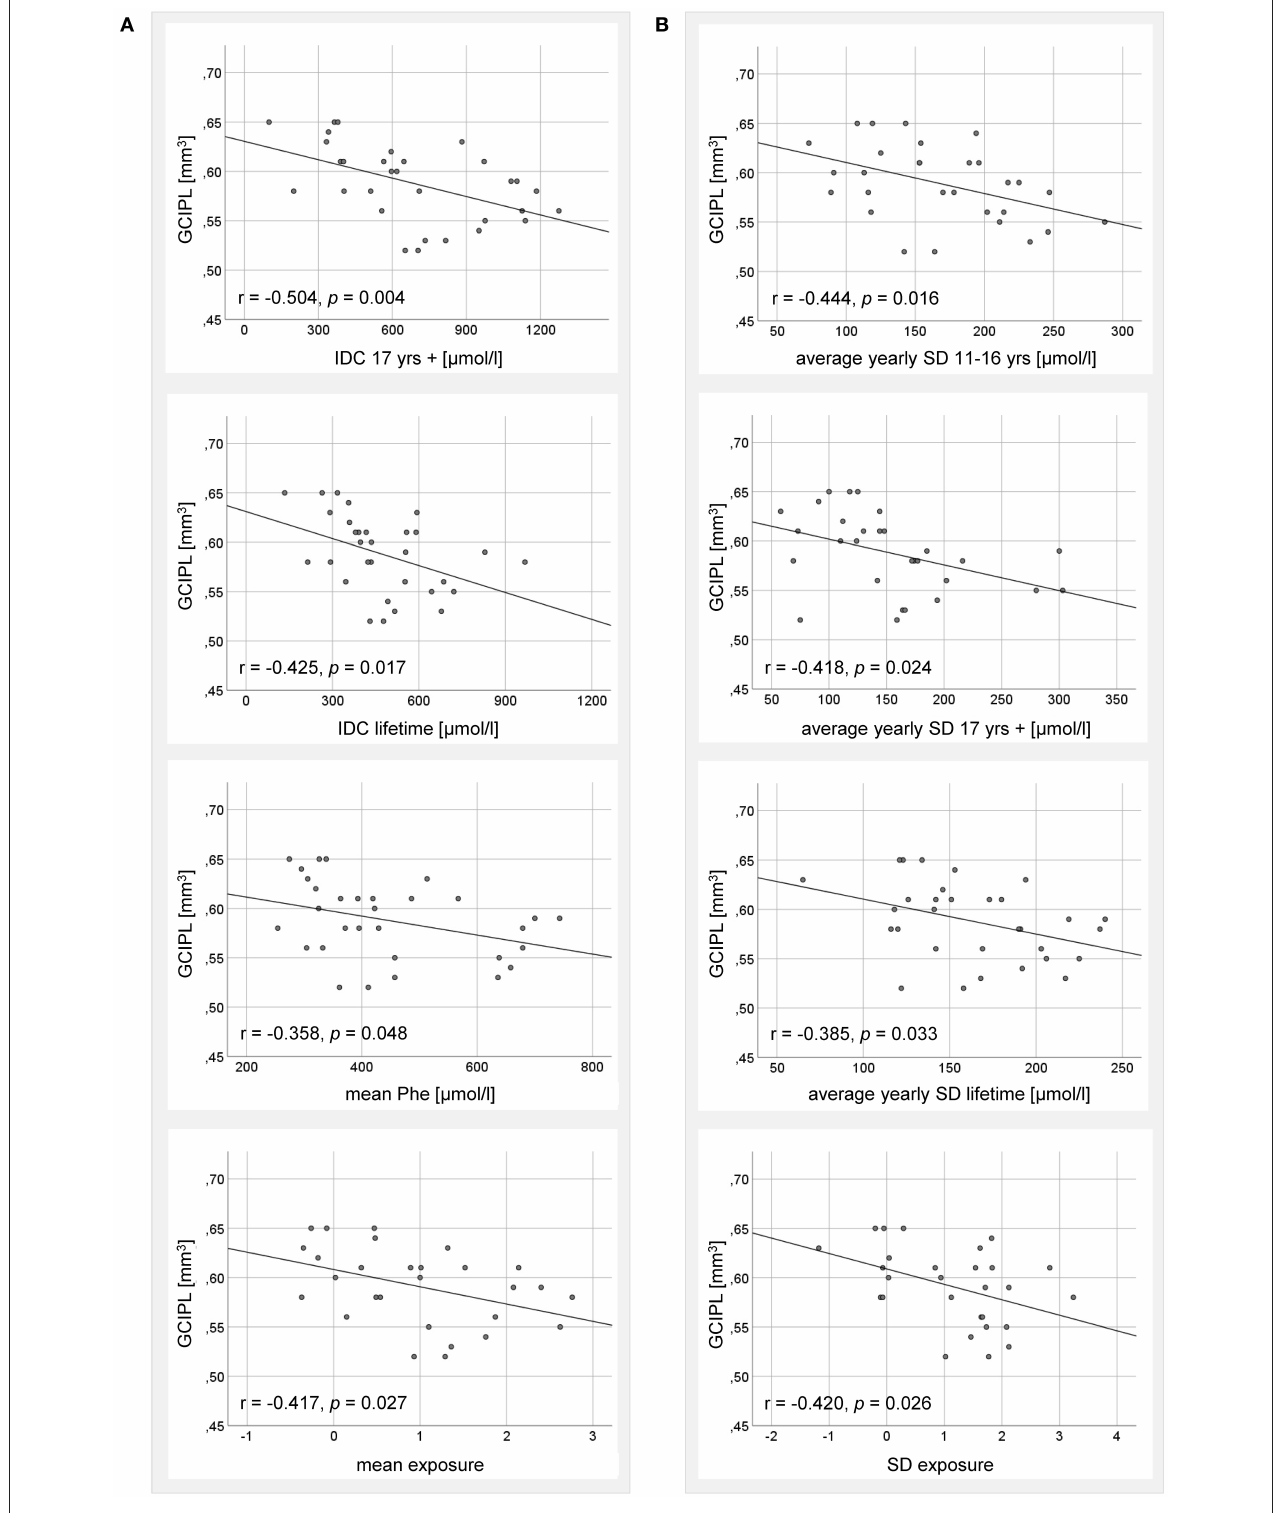
FIGURE 2 | Correlation analysis between GCIPL volume of adult ETPKU patients 18–33 years of age ( N = 32) and metabolic indices for (A) Phe elevation, and (B) Phe variability. IDC; average of yearly median Phe levels. The Pearson r - and p -values are indicated. The relationship of the correlating variables was linear, as depicted by the continuous